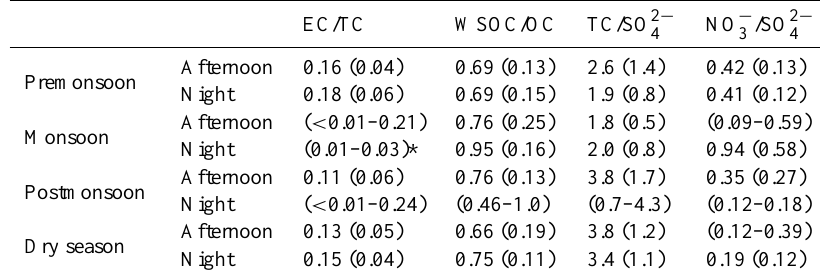
Table 3a. Mass ratios between chemical compounds in PM 10 . Averages and standard deviations (in parenthesis) are reported. For the sets including ≤ 4 samples, only the range of variation is given: (min–max). Weighting factors have been applied to EC/TC and WSOC/OC ratios in the low concentration regime (conc. < 5 × DL) of EC and